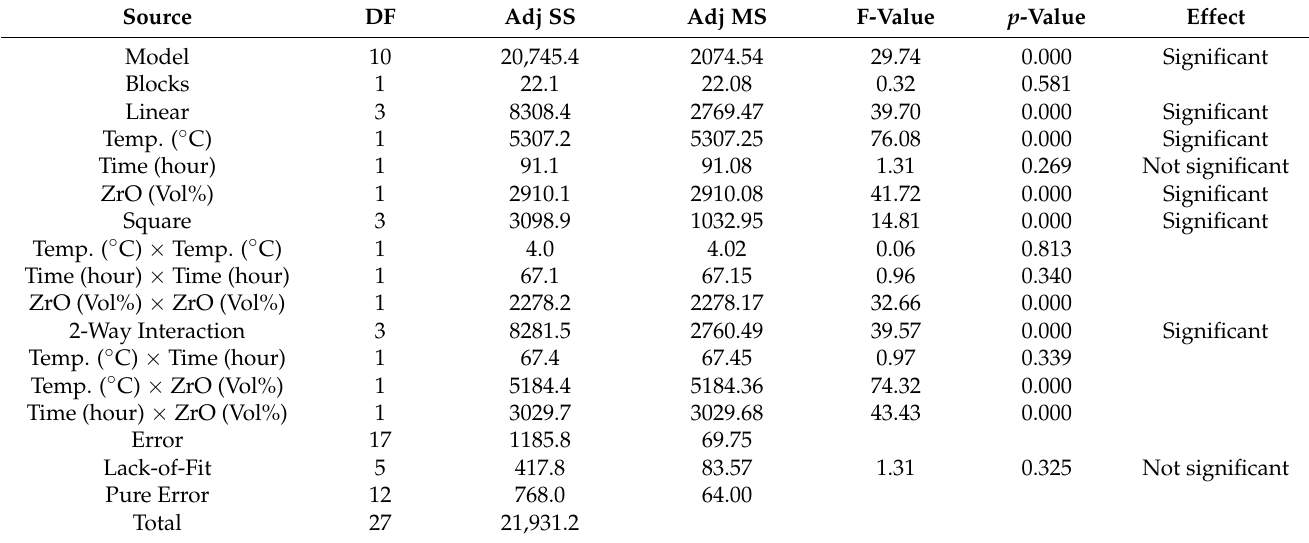
Table 6. The analysis of variance of UTS by